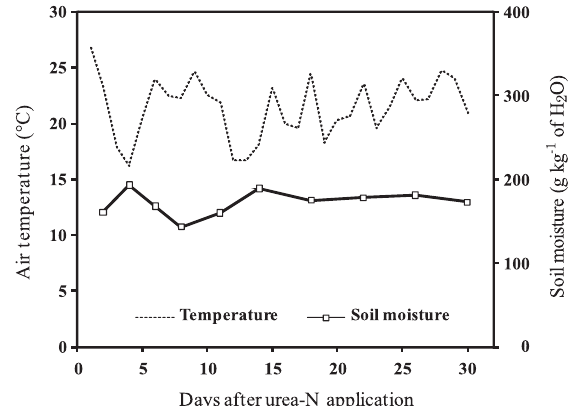
figure 2. mean air temperature and soil moisture content in the surface layer (0 - 20 cm) during the experiment performed in piracicaba, são paulo,